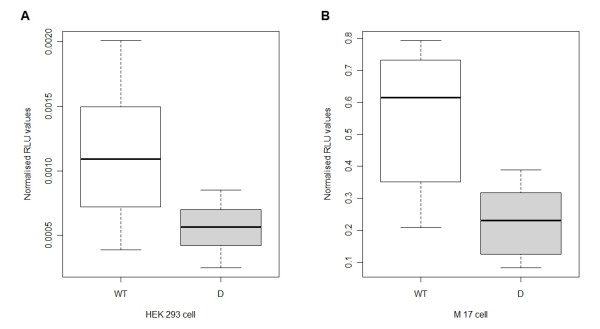
The DJ-1 16 bp deletion variant exhibited significantly reduced transcription levels compared to the wild-type (P < 0.0001) in two different cell lines. Box plots of dual-luciferase assays of the wild-type and deletion variant using (A) HEK293 cells and (B) neuroblastoma M17 cells. They include median (horizontal line within box), inter-quartile interval i.e. 25th to 75th percentile (box) and the range of variation (whiskers). The 2 kb promoter fragments (containing either wild-type sequence or the deletion) were linked to the luciferase gene and the constructs were transfected into two mammalian cell lines. For each experiment, firefly luciferase activity was divided by renilla activity to normalize for transfection efficiency. Data are representative of four transfection experiments (triplicate points obtained over four independent experiments). WT: wild-type; D: deletion variant; RLU: relative light units.